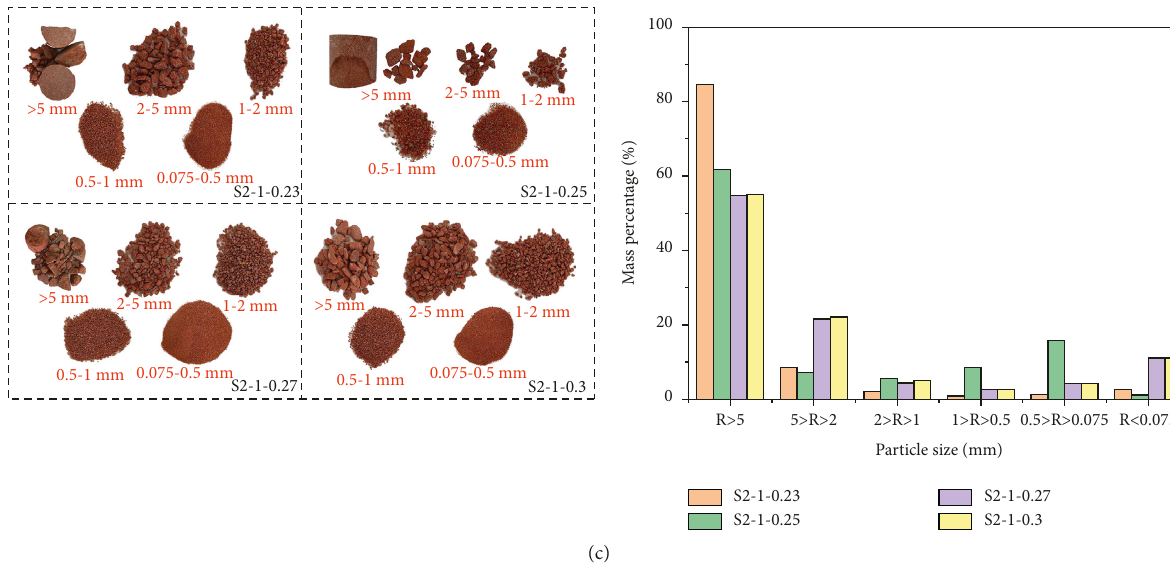
Figure 10: Fragments and the corresponding mass percentage of (a) granite, (b) cyan sandstone, and (c) red sandstone after different strain rate